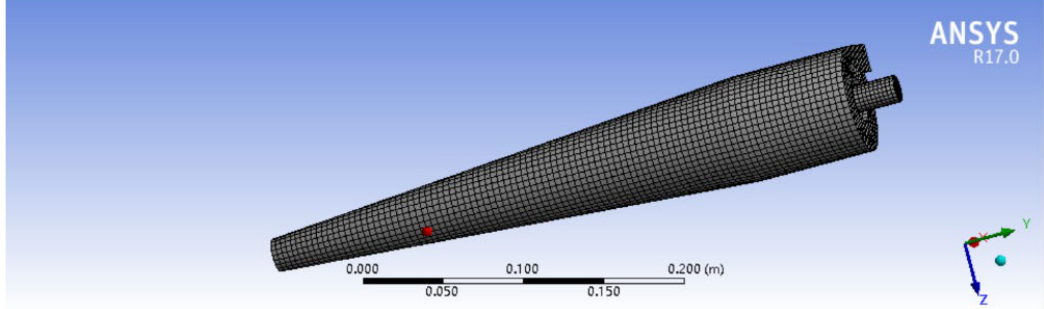
Figure 2. Grid division of the cyclone.